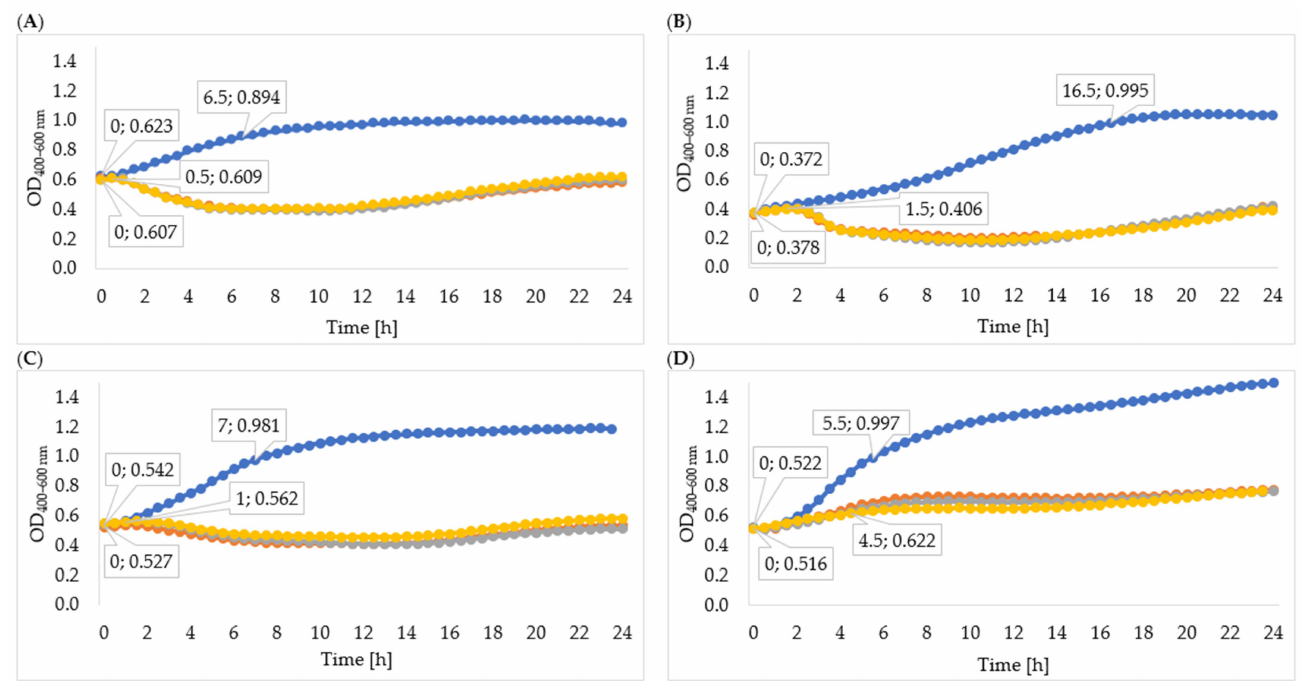
Figure 3. Growth curves of tested bacteria: ( A )— Enterobacter cloacae KKP 3082; ( B )— Serratialiquefaciens KKP 3654; ( C )— Enterobacter cloacae KKP 3684; ( D )— Serratia marcescens KKP 3687. The figure shows the beginning and the end of the logarithmic growth phase for control and tested bacterial strains after addition of specific phages multiplied for 72 h (MOI 1.0), n = 10. Blue line—control culture, orange line—culture infected with phages propagated for 24 h, grey line—culture infected with phages propagated for 48 h, yellow line—culture infected with phages propagated for 72